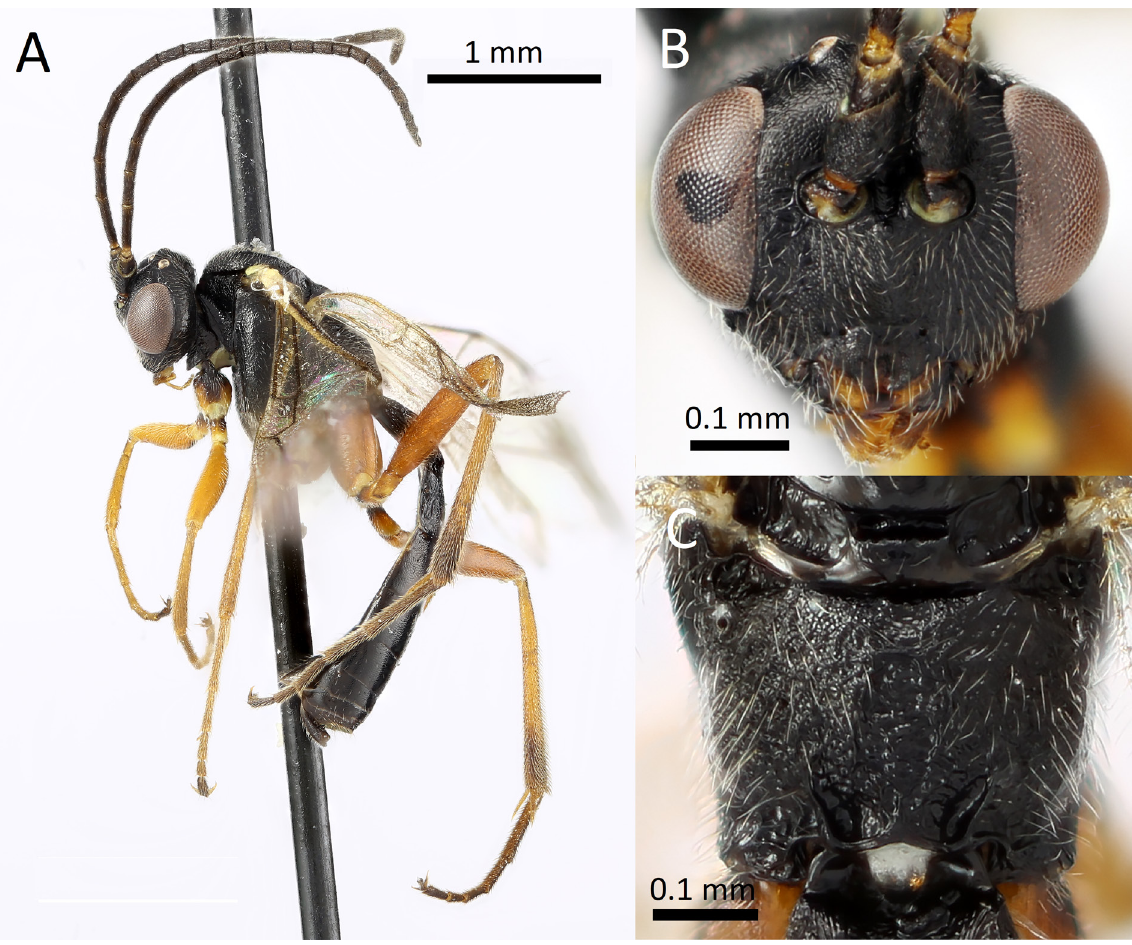
Fig. 10. Woldstedtius aureotibialis sp. nov., paratype, ♀ (NHRS-HEVA000011632). A . Habitus, lateral view. B . Head, anterior view. C . Propodeum, dorsal view. Photos: Alexander